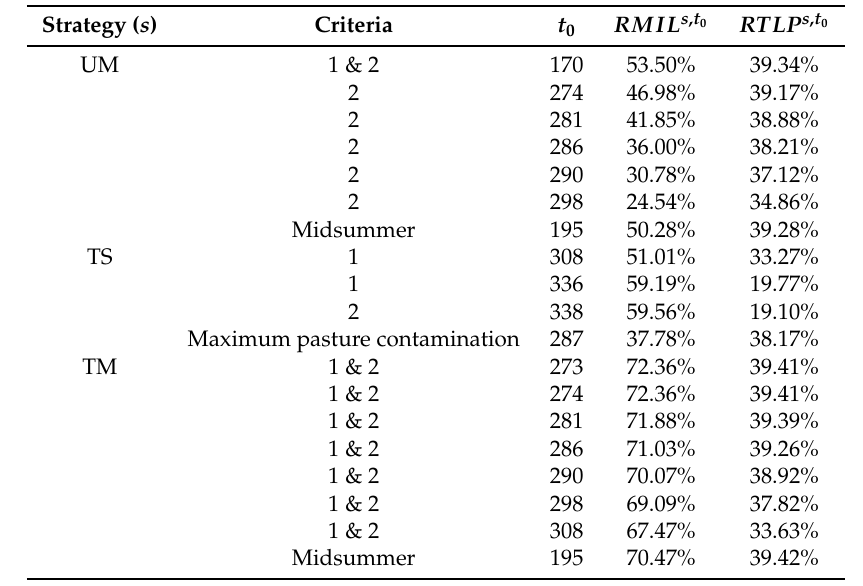
Table 2. Indexes reduction in the mean infection level (RMIL) and reduction in the total lost probability (RTLP) for strategies UM, TS and TM with the anthelmintic